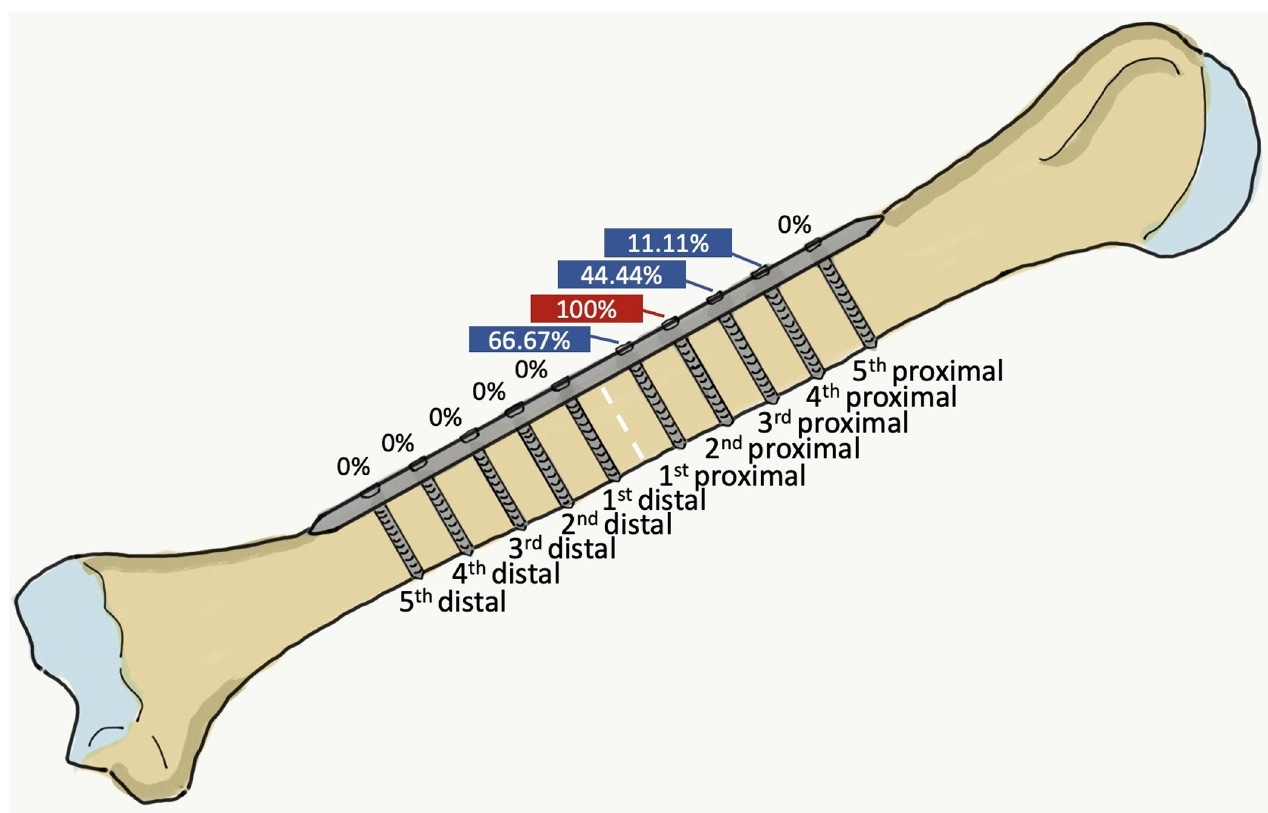
Fig 5. Anterior view of a right upper arm, showing an imaginary fracture line at the midpoint between the tip of the greater tuberosity and the lateral epicondyle (white dotted line), indicating the risk of iatrogenic radial nerve and/or profunda brachii artery injury of each screw hole.